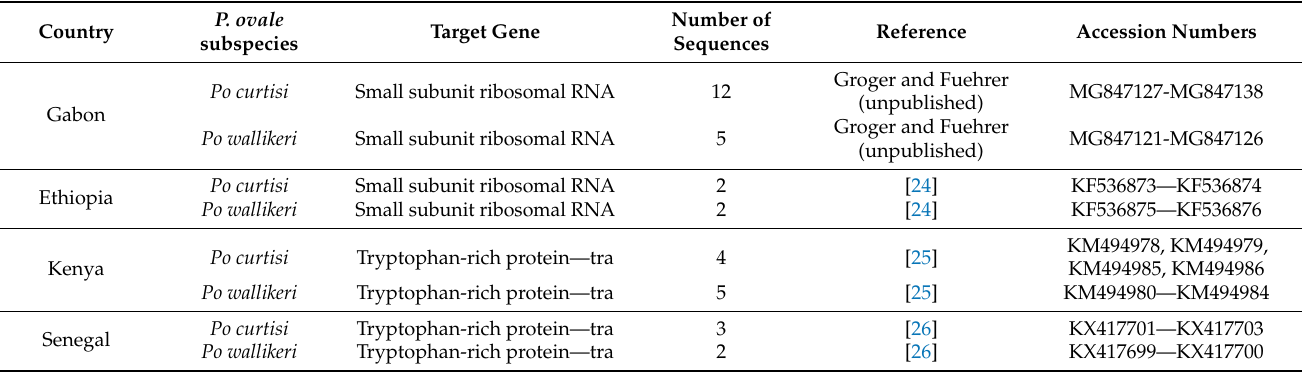
Figure 1. Flowchart of data retrieval and analysis process. Table 1. Summary of sequences retrieved and utilized in this